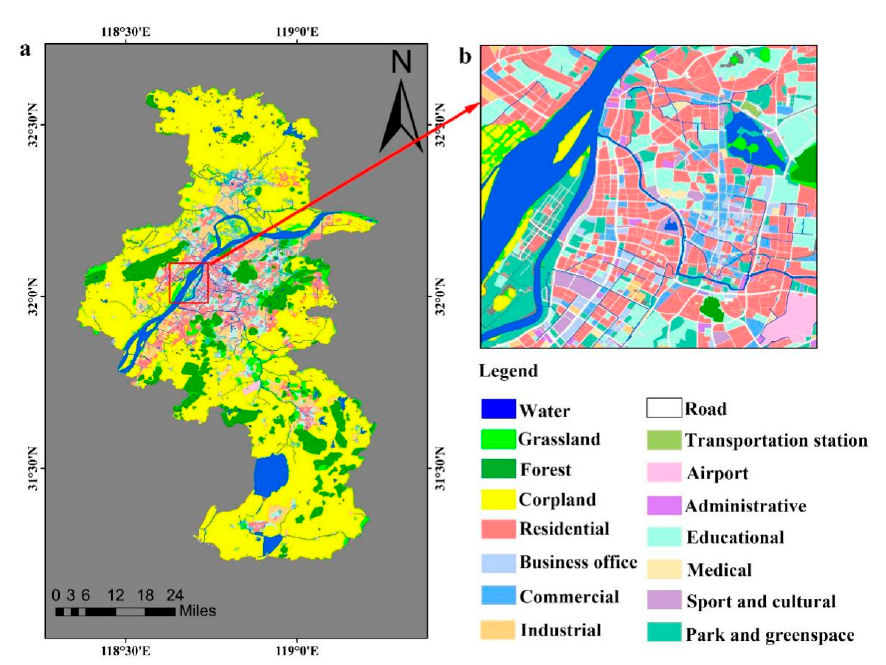
Figure 10. ( a ) The map of EULUC-Nanjing in 2018. ( b ) Zoomed-in area of the red frame.